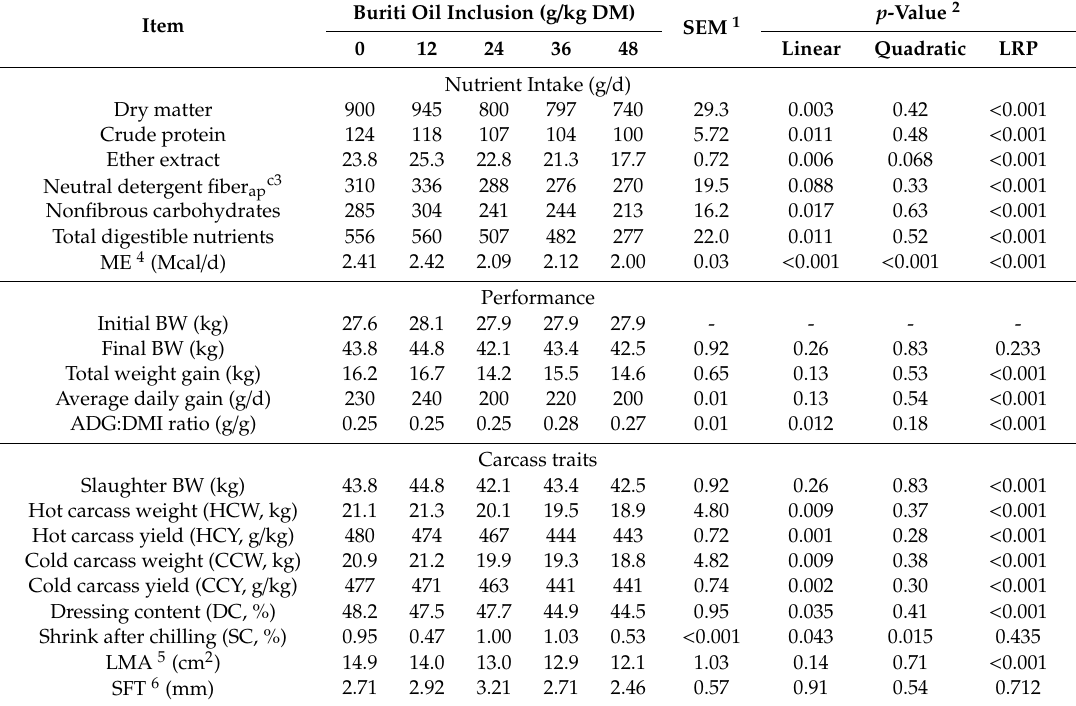
Table 3. Daily nutrient intake, performance and carcass traits of grass-fed Santa Ines lambs receiving a buriti ( Mauritia flexuosa L .) oil dietary